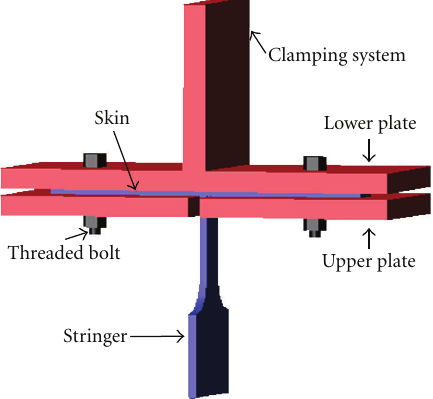
Figure 3: Self-made lamping systemadopted to perform T-pull